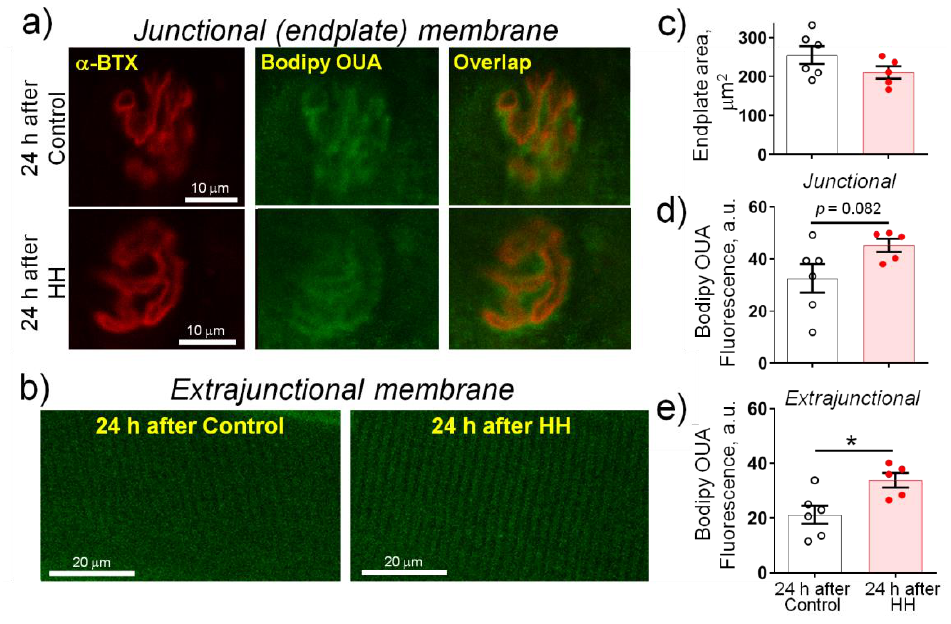
Figure 6. Exposure to hypobaric hypoxia (HH) at a pressure equivalent to an altitude of 3000 m for 3 h increases the α 2 Na,K-ATPase membrane abundance in the rat diaphragm muscle. The measurements were carried out on muscles isolated 24 h after control or HH treatment. ( a ) Representative images of endplates dual-labeled with α -BTX (nAChRs, red channel) and Bodipy-conjugated ouabain ( α 2 Na,K-ATPase, green channel). Overlap—orange. Scale bars—10 µ m. ( b ) Representative images of extrajunctional membrane regions. Scale bars—20 µ m. ( c ) Averaged area of endplates. ( d , e ) Averaged fluorescence intensity from the α 2 Na,K-ATPase staining (arbitrary units) in the junctional ( d ) and extrajunctional ( e ) membrane regions. The number of muscles corresponds to the number of symbols. One-way ANOVA followed by Bonferroni multiple comparisons test. * p < 0.05—compared to the corresponding control.